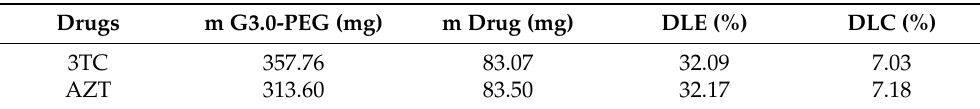
Figure 5. Images of AO/PI dual stained BJ cell line treated by G3.0, G3.0@mPEG, 3TC@G3.0@mPEG and AZT@G3.0@mPEG solutions at 200 µ g/mL within 24 h, observed under 525 and 700 nm laser channels. The scale bar is 150 µ m. Table 2. DLE and DLC of G3.0-PEG loading